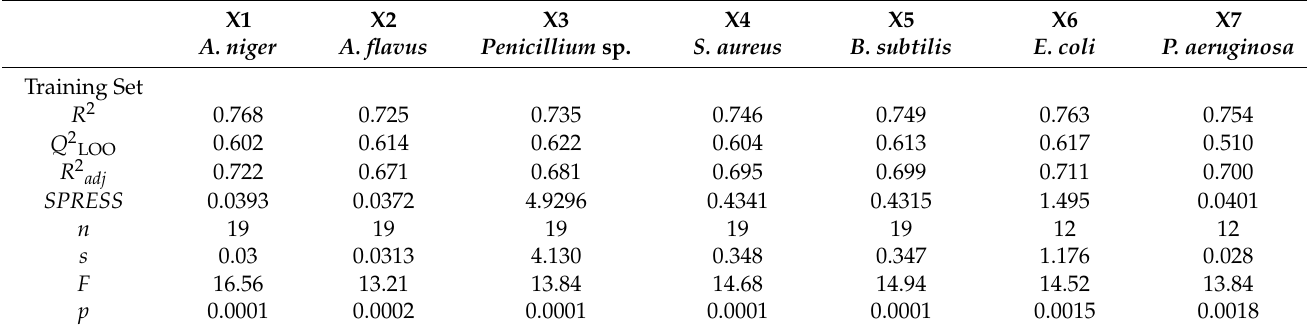
Table 4. Training set parameters of quantitative structure–activity relationship models of triazolothiadiazine compounds for antifungal and antibiotic activities.